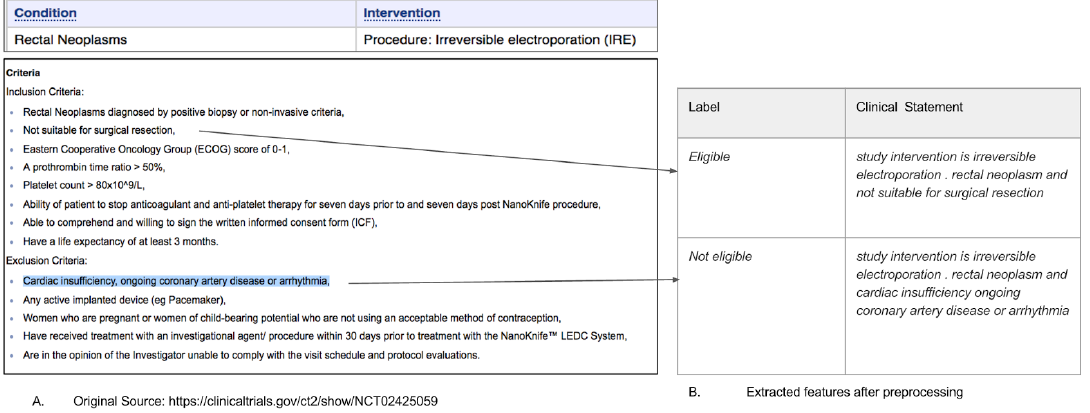
Figure 2. Extraction of labeled short clinical statements. The two example criteria indicated with the arrows were extracted from their original source, preprocessed, and